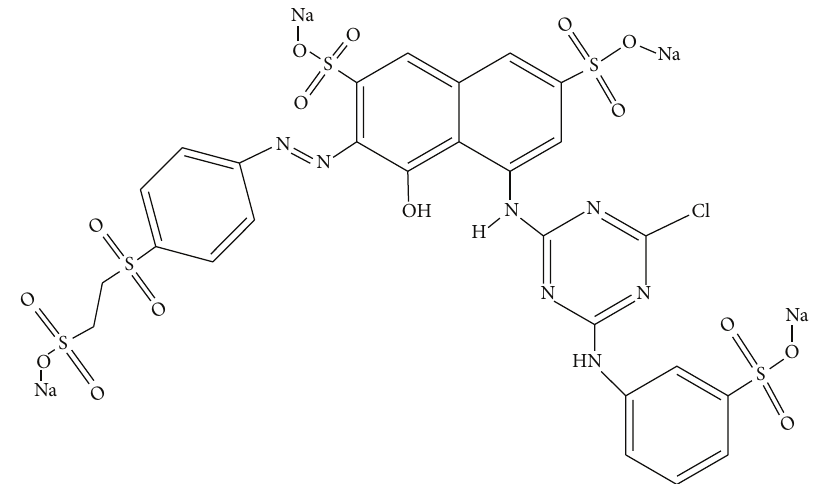
Figure 1: Chemical structure of the sulfonated azo dye Reactive Red 198 (RR).